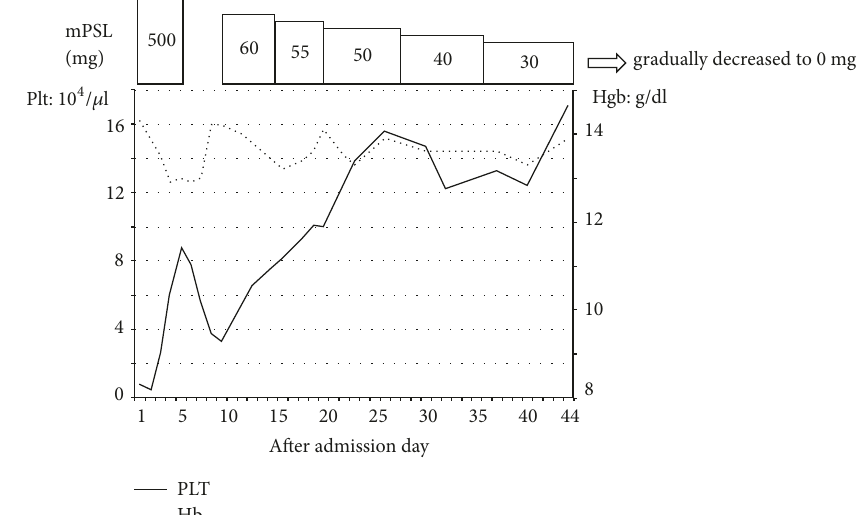
Figure 2: Transition of hemoglobin concentration and platelet count after development of idiopathic thrombocytopenic purpura (ITP) and subsequent treatment with corticosteroids. Solid line, platelets; dotted line, hemoglobin. The treatment procedure is also shown.